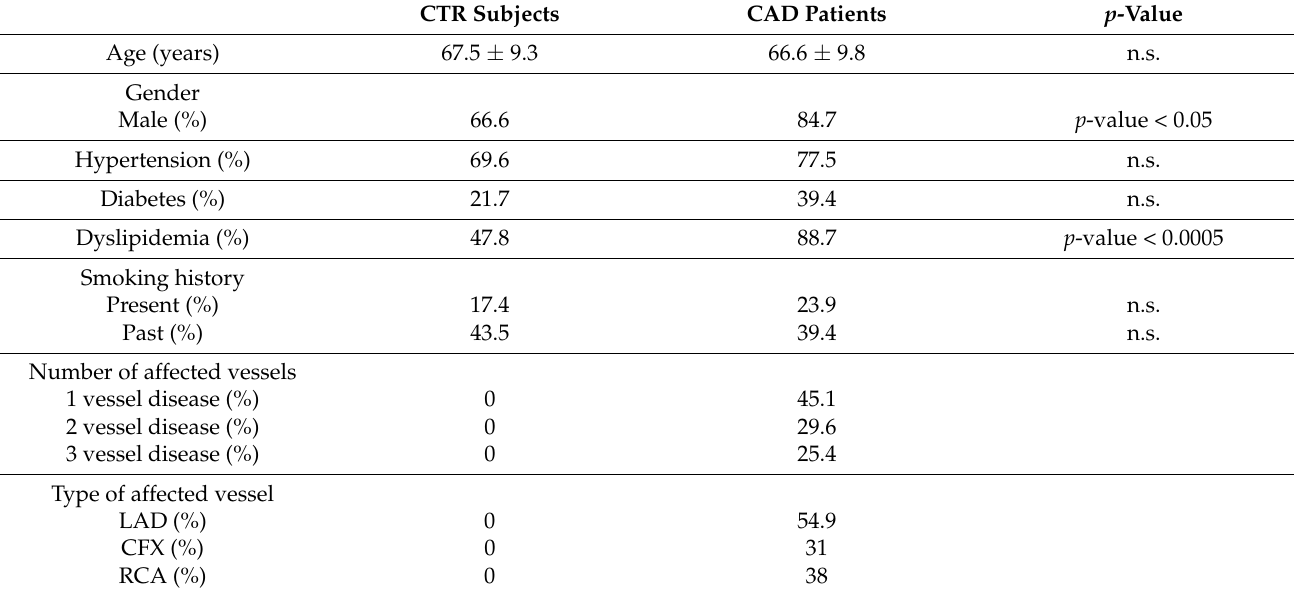
Table 1. Clinical features of CTR subjects and CAD patients